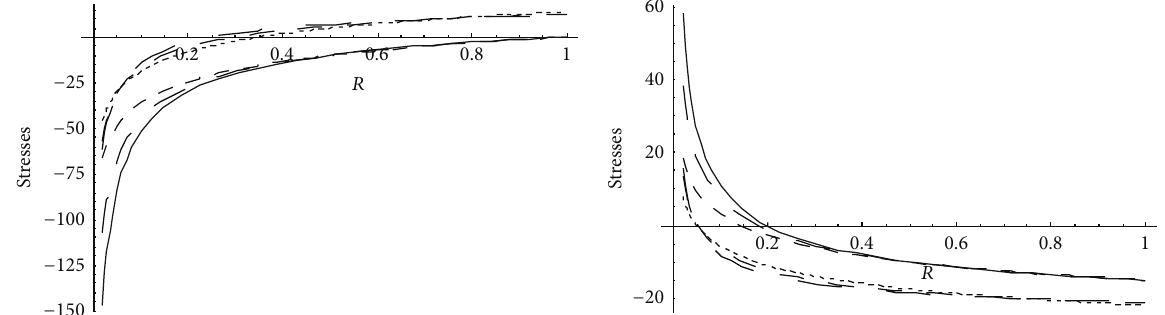
Figure 8: Nonhomogeneous transitional stresses for a thick-walled circular cylinder under internal ( 𝑃 1 = 5 ) and external pressure ( 𝑃 2 = 0 and 15).